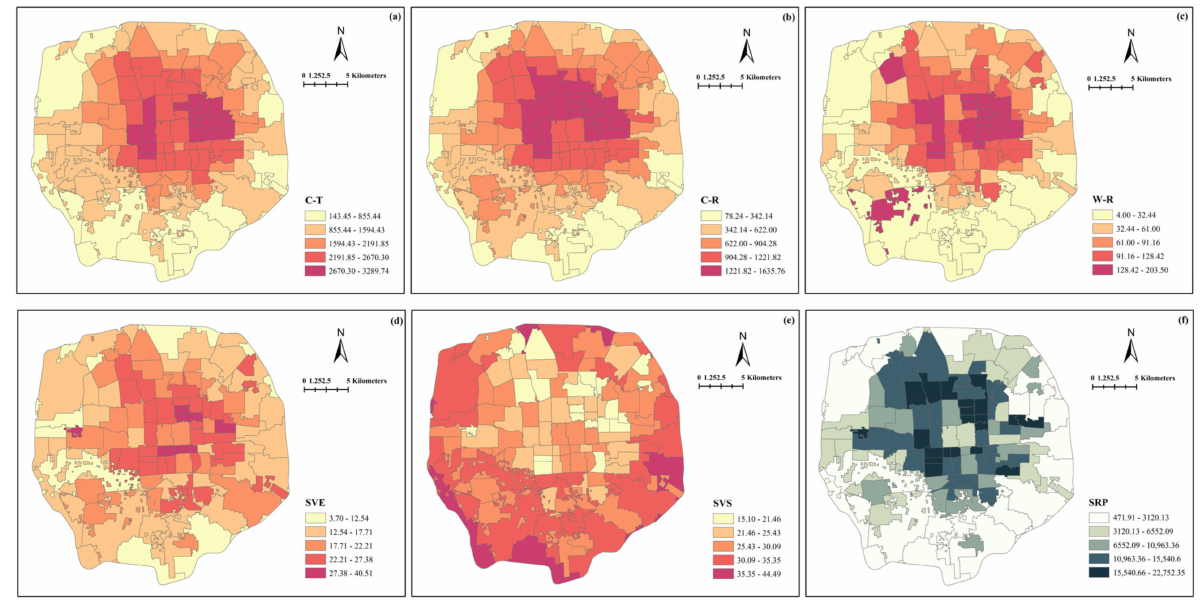
Figure 8. The spatial distribution of the top five perception factors of q value and DSP. ( a ) C-T ( b ) C-R ( c ) W-R ( d ) -SVE ( e ) SVS ( f ) DSP.